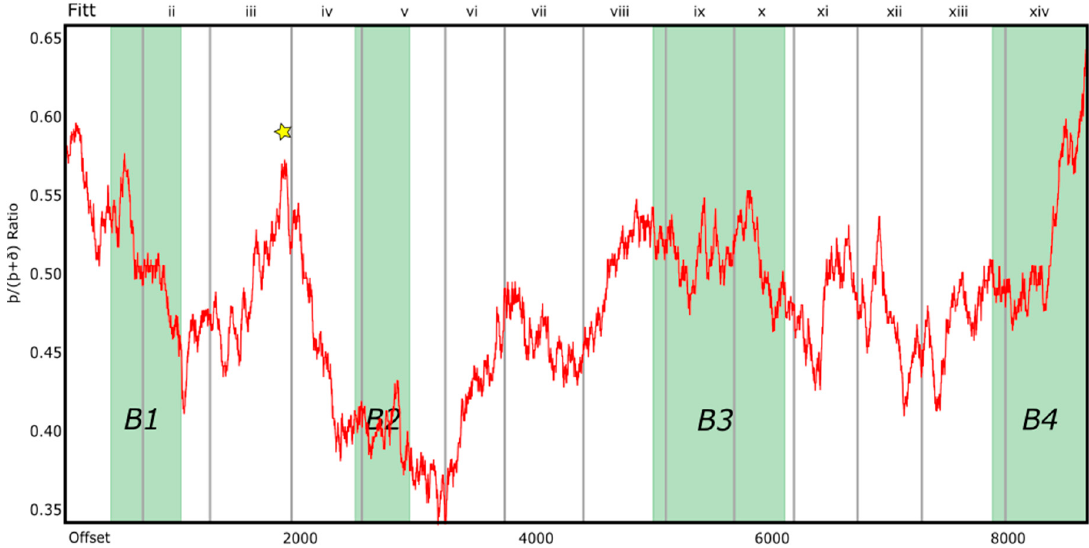
Figure 10. The moving ratio of þ to ð in Andreas , 500-word window.